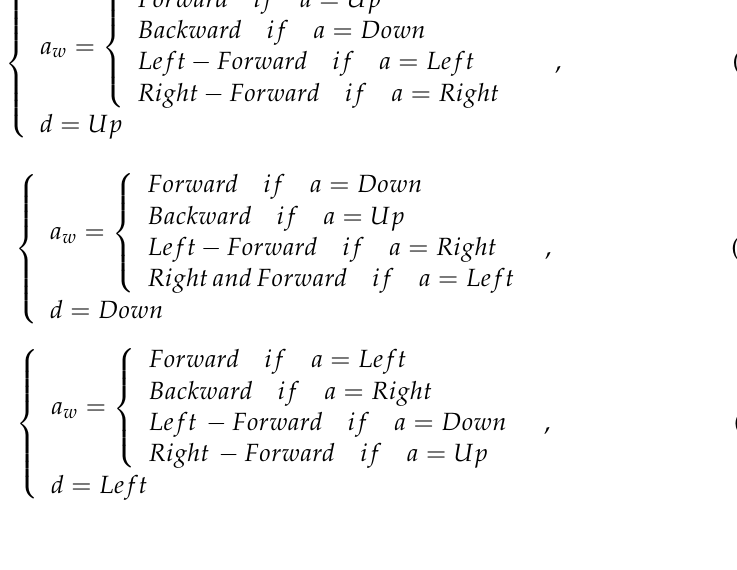
Figure 7. The representation of converting actual control commands from the simulation. ( a ) Con ‐ verter with the simulated inputs and the actual outputs; ( b ) representation of four control directions.